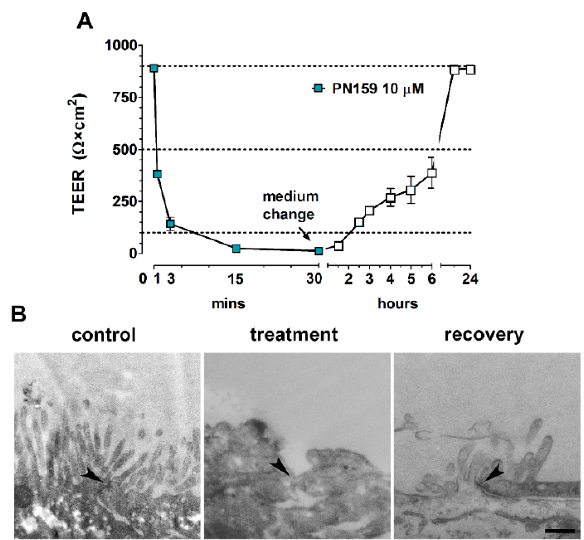
Figure 3. Reversible effect of PN159 peptide (10 µ M, 30-min treatment, 24-h recovery) on Caco-2 cells. ( A ) Kinetic analysis of transepithelial electrical resistance (TEER) after PN159 peptide treatment. ( B ) Transmission electron micrographs of cell–cell connections (arrowheads); bar = 400 nm.